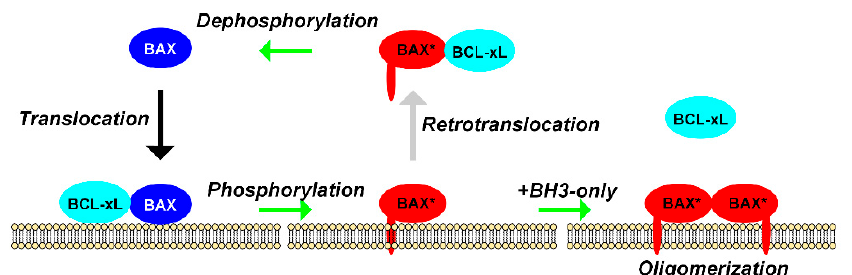
Figure 4. Schematic representation of the link between BAX phosphorylation and Translocation. Phosphorylated BAX (by AKT and other survival kinases) is maintained away from mitochondria while non-phosphorylated BAX is in the OMM, both in yeast and mammalian cells [80,83]. The interaction of BAX with BCL-xL stimulate both BAX translocation [15] and BAX retrotranslocation [13,15]. Heterodimers between phosphomimetic BAX and BCL-xL are more present away from mitochondria while heterodimers between non-phosphorylatable BAX and BCL-xL are more present at the OMM [68]. The release of the interaction between mitochondrial BAX and BCL-xL by BH3-only proteins (or BH3 mimetics) triggers the oligomerization/activation process of BAX [15].